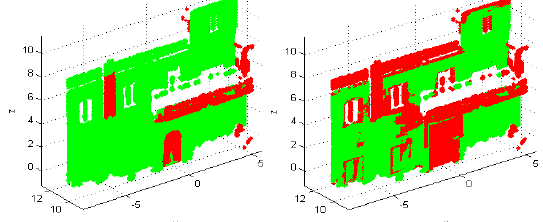
Figure 4. The ds -threshold influences the results observed during the first phase of the segmentation process. (a) Sub- segmentation with ds = 0.15 m, (b) Over-segmentation with ds = 0.03 m. Green-colored points are belonging to the main primary